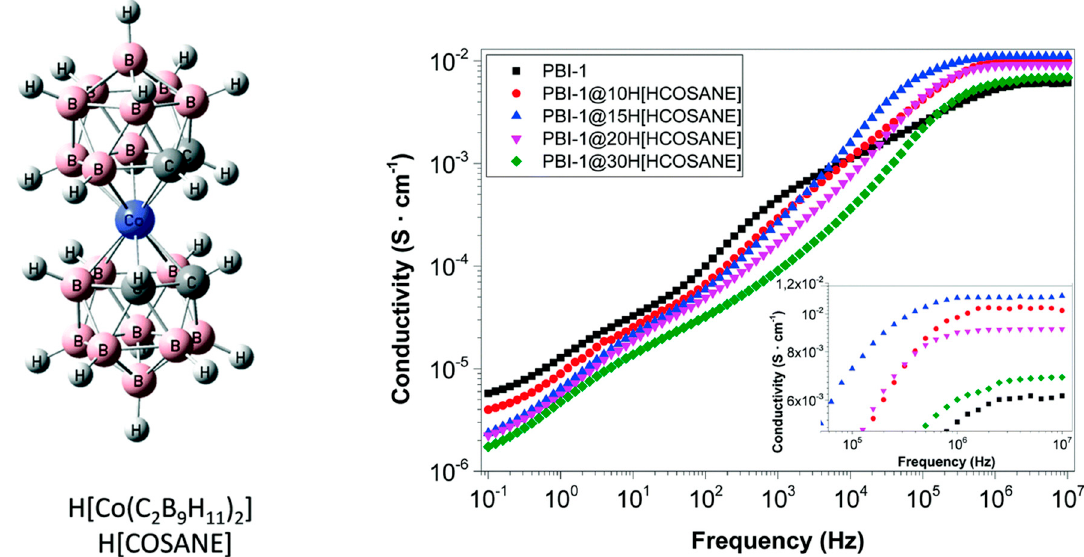
Figure 16. Ball and stick view of H[COSANE] ( left ) and Bode diagram for composite membranes of PBI containing 15 wt.% of H[COSANE] ( right ). Reproduced from [148] with permission of the Royal Society of Chemistry.